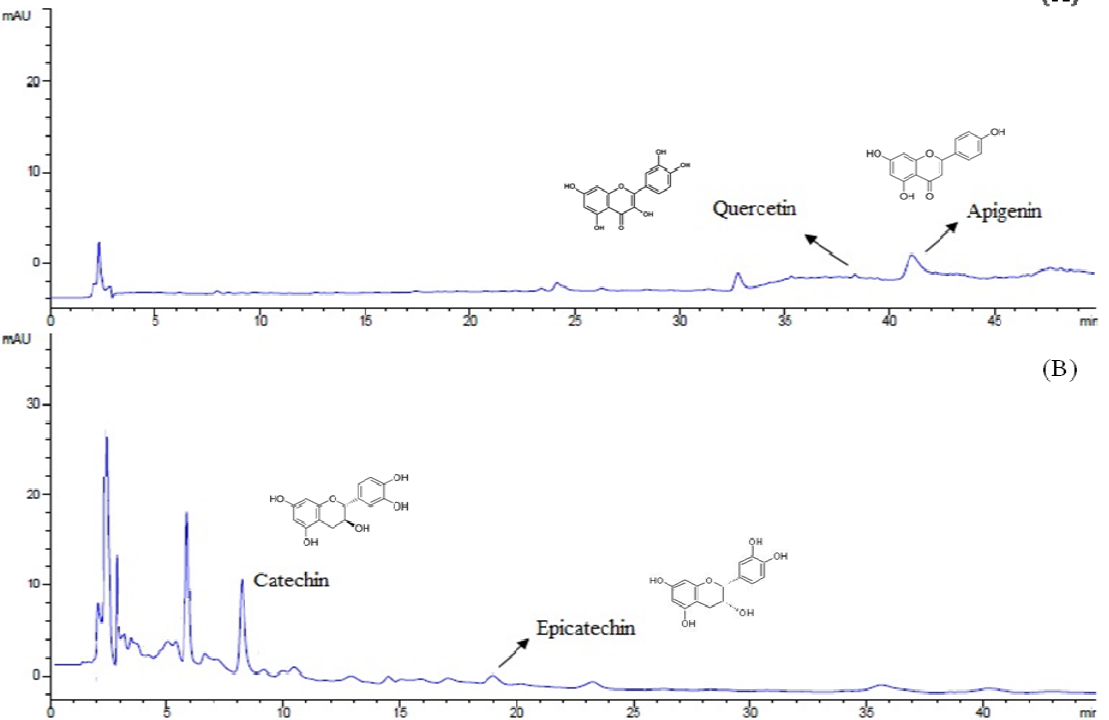
Figure 1. Chromatograms (HPLC) for flavonoids ( A ) at 350 nm and tannins ( B ) at 280 nm of A. angustifolia aqueous